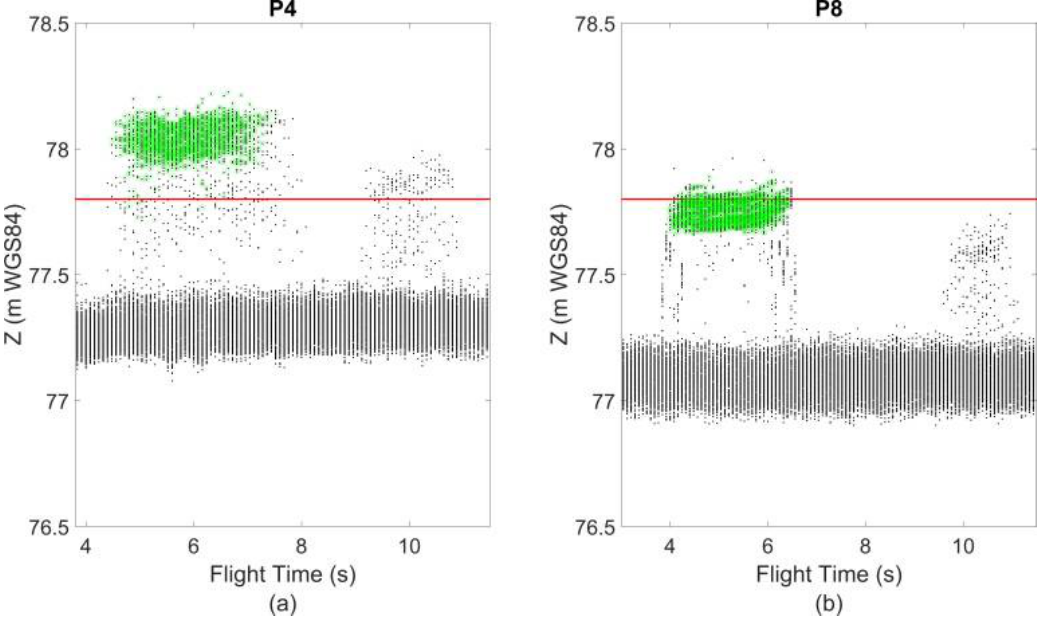
Figure 11. Returns from the top of the box in ( a ) P4 and ( b ) P8, in green, and ground returns, in black. The red line is the expected box top position. The cluster of returns on the right-hand side of each figure is another ground target (a sphere) that is not included in the analysis.